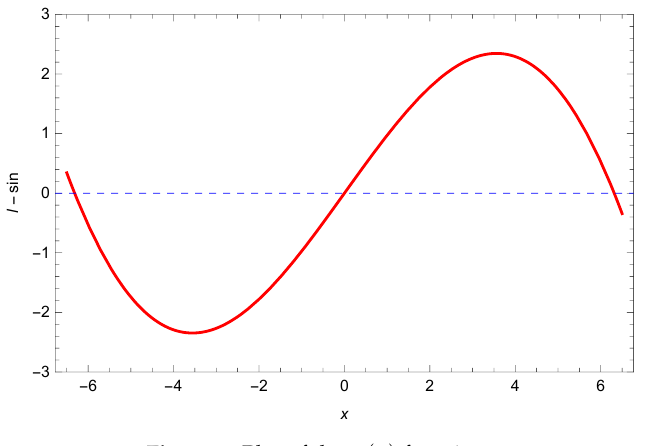
Figure 2. Plot of the l s ( x )